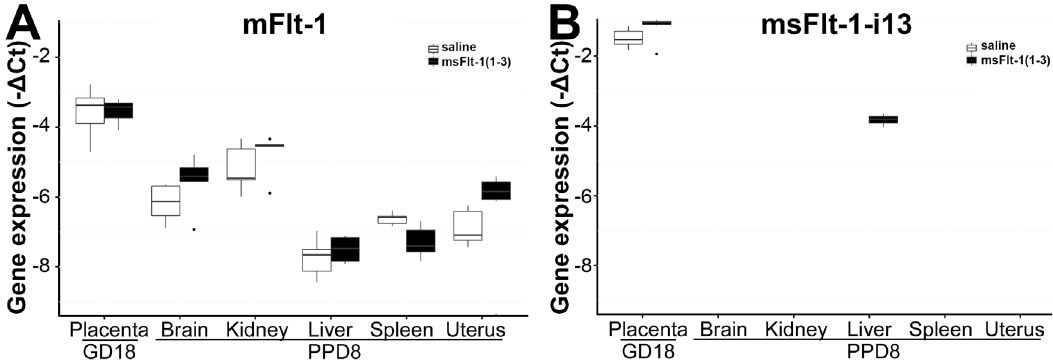
Figure 3. Profiling of mFlt-1 and msFlt-1-i13 expression. ( A ) Boxplots show the endogenous expression profile of the mouse transmembrane Flt-1 mRNA in placentas harvested on gestational day (GD) 18 and in five tissues harvested on postpartum day (PPD) 8. Endogenous Flt-1 mRNA expression was highest in the placenta in both the non-treated (saline) and the msFlt-1(1-3)-treated mice. ( B ) Boxplots show the endogenous expression profile of the mouse sFlt-1-i13 mRNA in placentas harvested on GD18 and in five tissues harvested on PPD8. Endogenous msFlt-1-i13 mRNA expression was restricted to the placenta in control animals, and transgenic msFlt-1(1-3) expression was detected in the placenta and the liver.